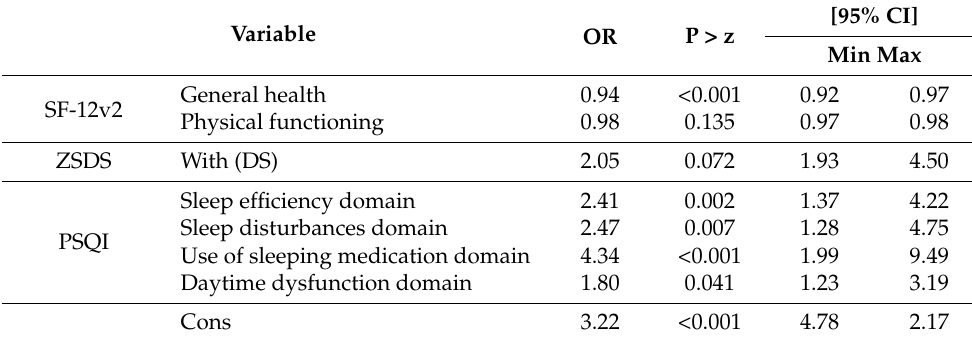
Table 4. Final multiple logistic regression model associated with IPAQ.